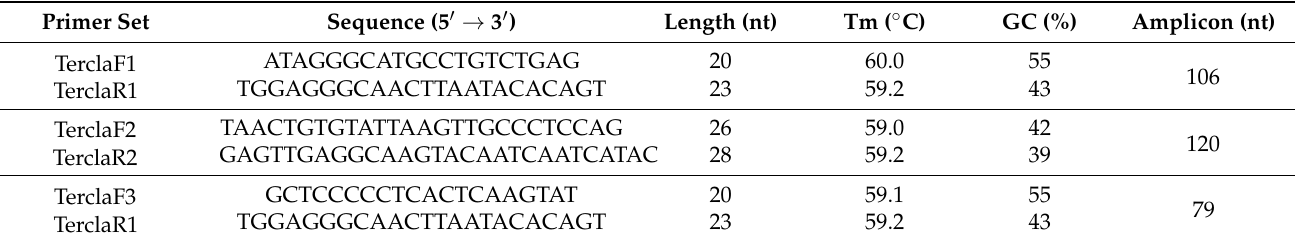
Table 2. Set of primers designed and